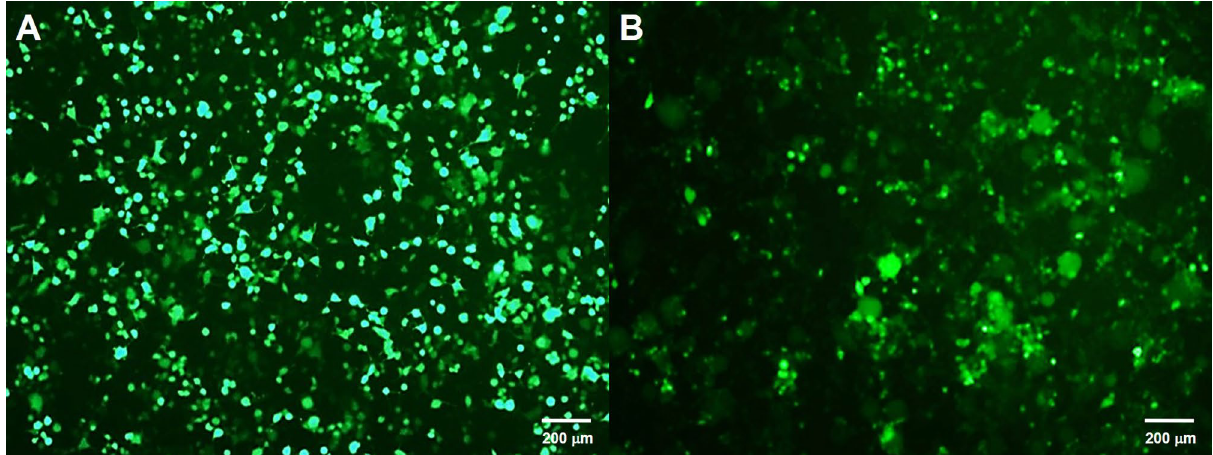
Figure 1. GFP expression in cells at 48-h post-transduction with the 2nd and 3rd lentiviral vectors. ( A ) Lentiviral vector 2A with pCMV-dR8.2 dvpr as the packaging plasmid produced the most lentivirus particle compared to 2B, and ( B ) Lentiviral vector 3B produced a smaller number of lentivirus particle compared to